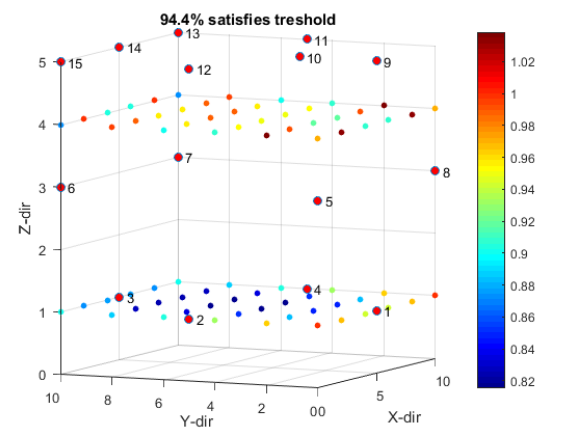
Figure 10. The optimal geometric configuration satisfying the threshold in terms of precision for 94.4% of the user